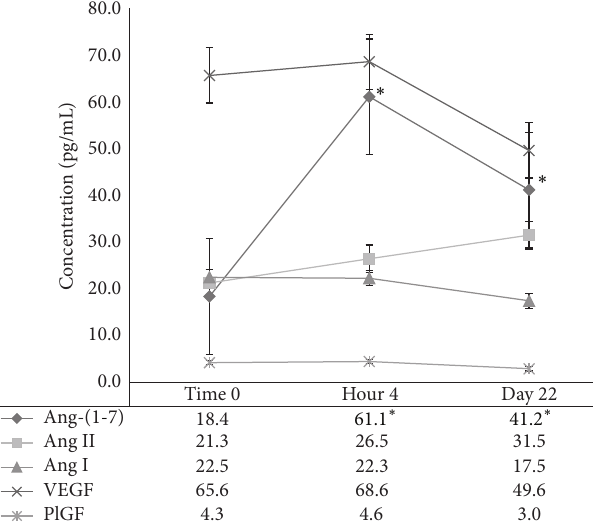
Figure3:Plasmaconcentrationsofangiotensinsystempeptidesand angiogenic hormones over time are shown. The data points repre- sent median values for the pretreatment (Time 0) and posttreatment blood draws. The 4-hour and day 22 posttreatment Ang-(1-7) levels were increased over baseline ( 𝑃 < 0.05 ). Standard error bars are